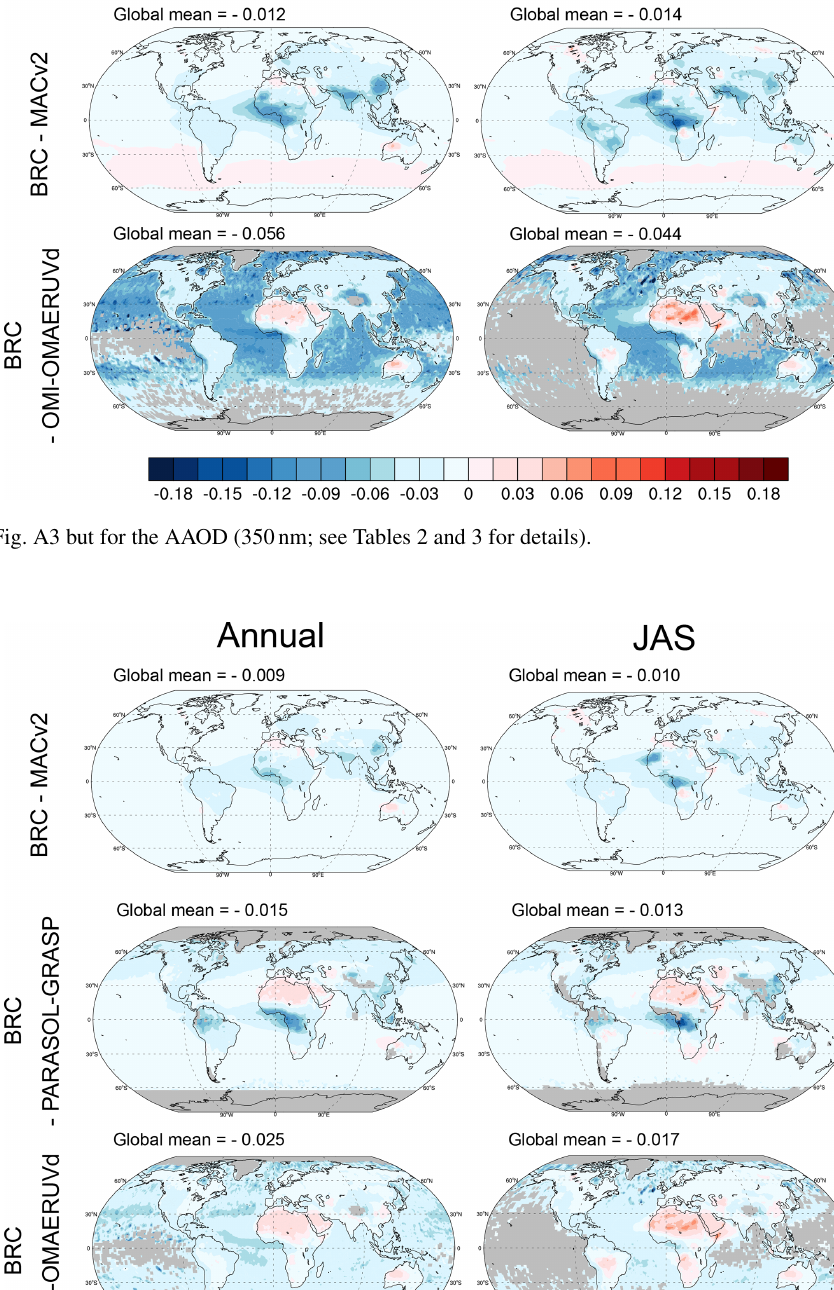
https://doi.org/10.5194/acp-22-12167-2022 Atmos. Chem. Phys., 22, 12167–12205,